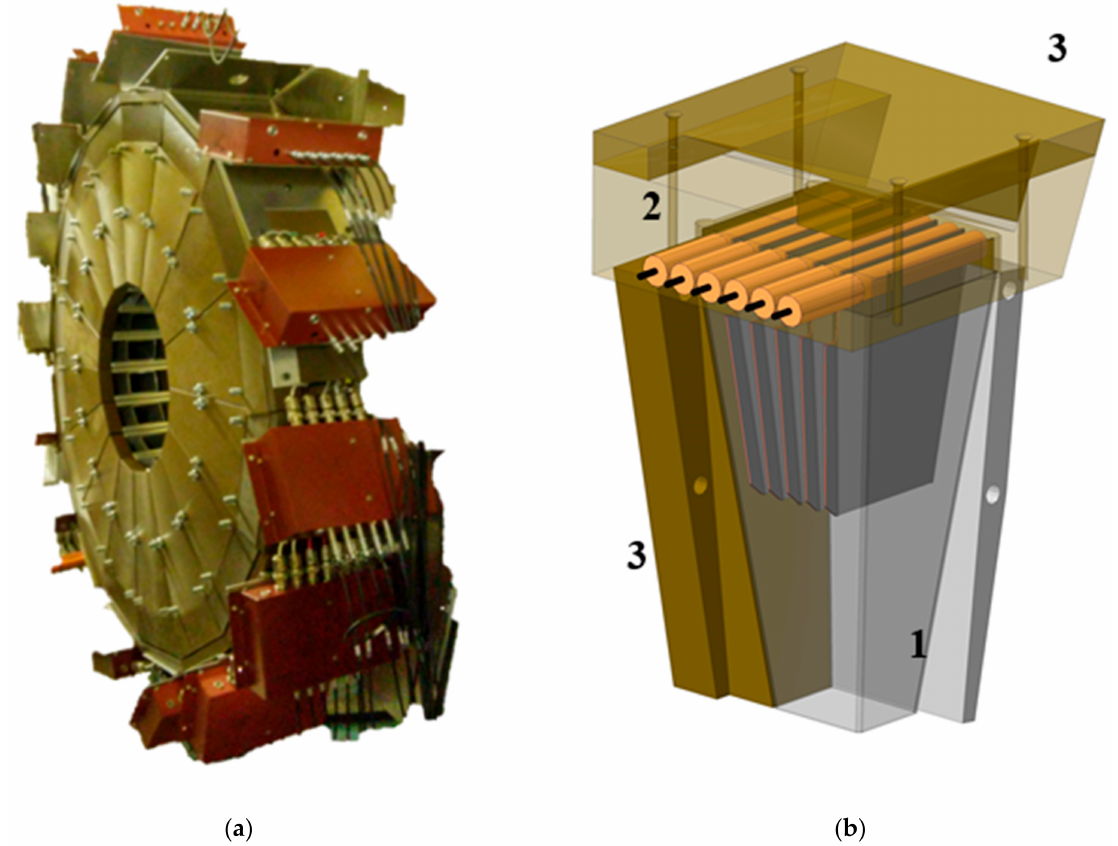
Figure 3. ( a ) The 90-degree detector section of the DN-6 diffractometer. The detectors are located in boron-polyethylene covering for background protection and consist of sixteen sectoral collimators modules and detector blocks. The red boxes are pre-amplifier modules of neutron counters. ( b ) The layout of the sectoral detector module. The cadmium inner collimator unit (1), placement of the six neutron counters (2), and the surrounding shielding of boron-containing